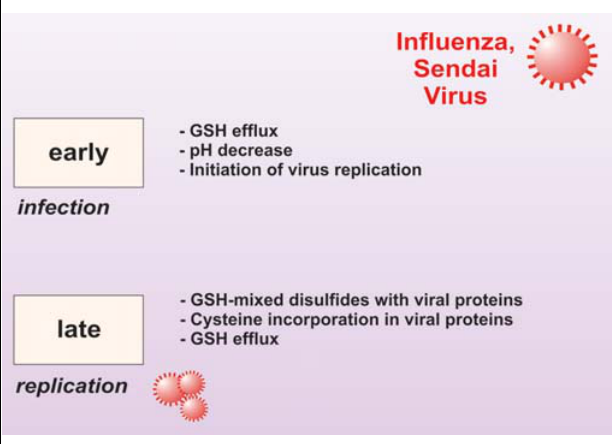
FIGURE 3 | Modulation of intracellular GSH level during Sendai and Influenza virus infection. In the early phase of infection, host cell membrane perturbation causes decrease of intracellular pH and GSH efflux allowing virus cycle start. In the late phase of infection, GSH is also engaged in forming mixed disulfides with viral proteins. GSH intracellular levels are further decreased as its component cysteine is incorporated into viral